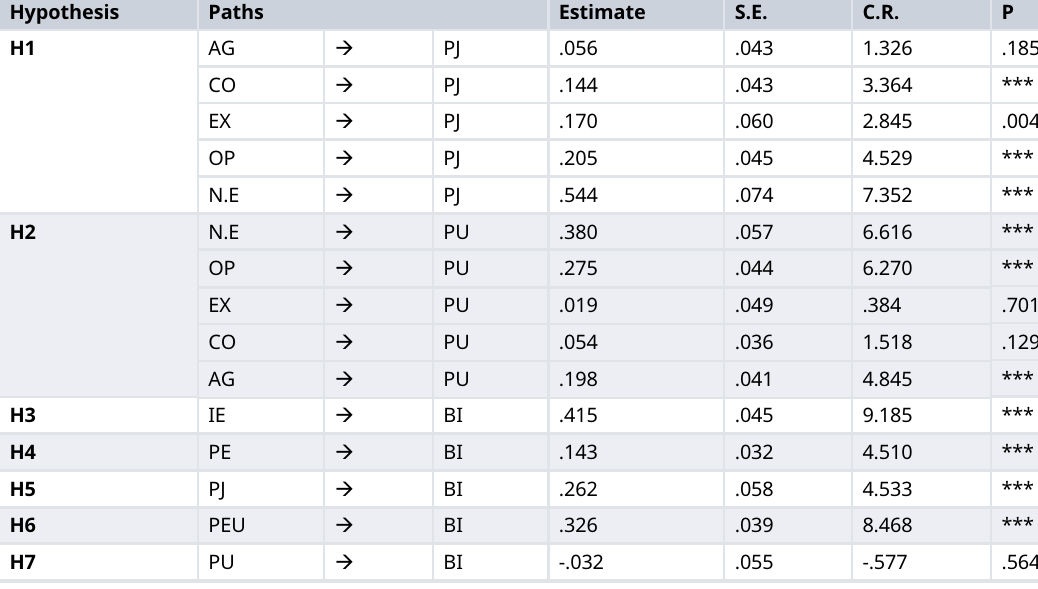
Table 4. Results of the study for each hypotheses